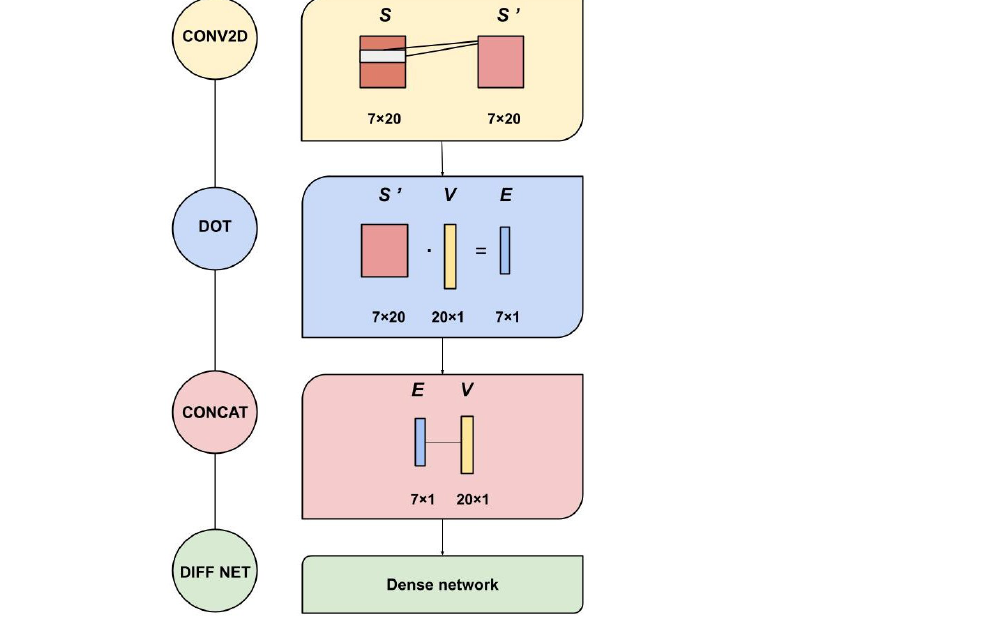
Figure 1. Constituent modules of ACDC-NN-Seq. CONV2D: a 2D-convolution operation applied to S (1D inputs) with 20 filters with kernel ( 1,20 ) and stride ( 1,1 ) ; DOT: dot product is applied to S’ processed information with the variation encoding vector V; CONCAT: all the 27 features are concatenated and used as input in a Dense Network (DIFF NET).